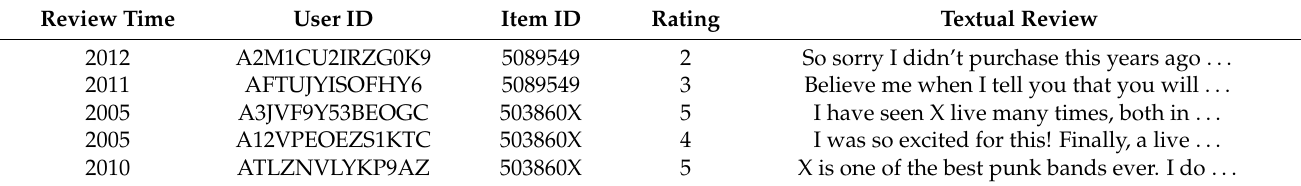
Table 1. First 5 rows example of the preliminary dataset of 2.92 M rows with 5 columns.